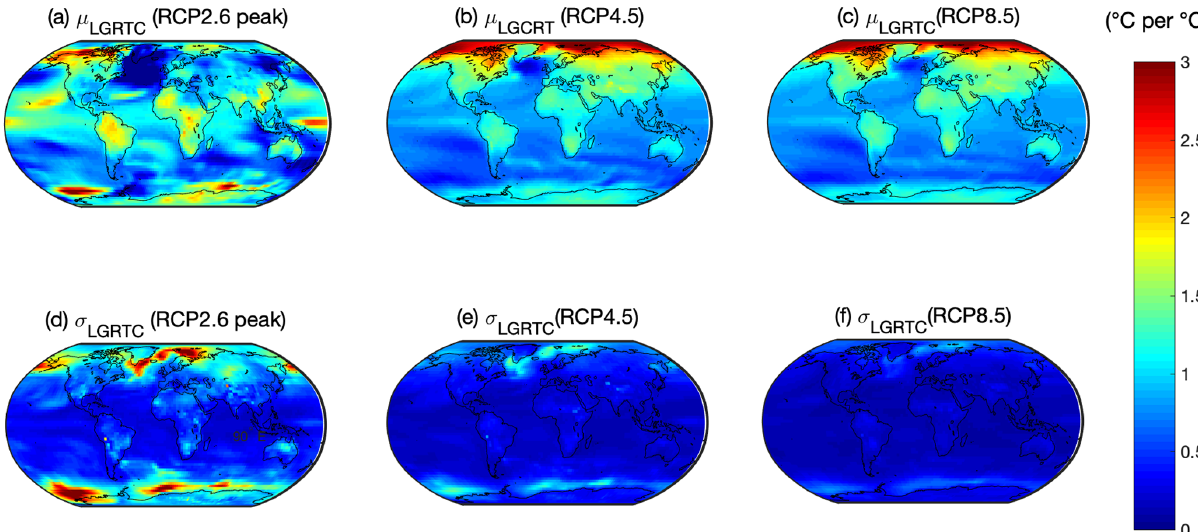
Figure 1. The LGRTC in RCP2.6, RCP4.5 and RCP8.5 scenarios analysed from a multi-model ensemble of CMIP5 simulations. Panels (a–c) show the multi-model mean LGRTC, µ LGRTC , while (d–f) show the multi-model standard deviation in LGRTC, µ LGRTC , for each scenario.